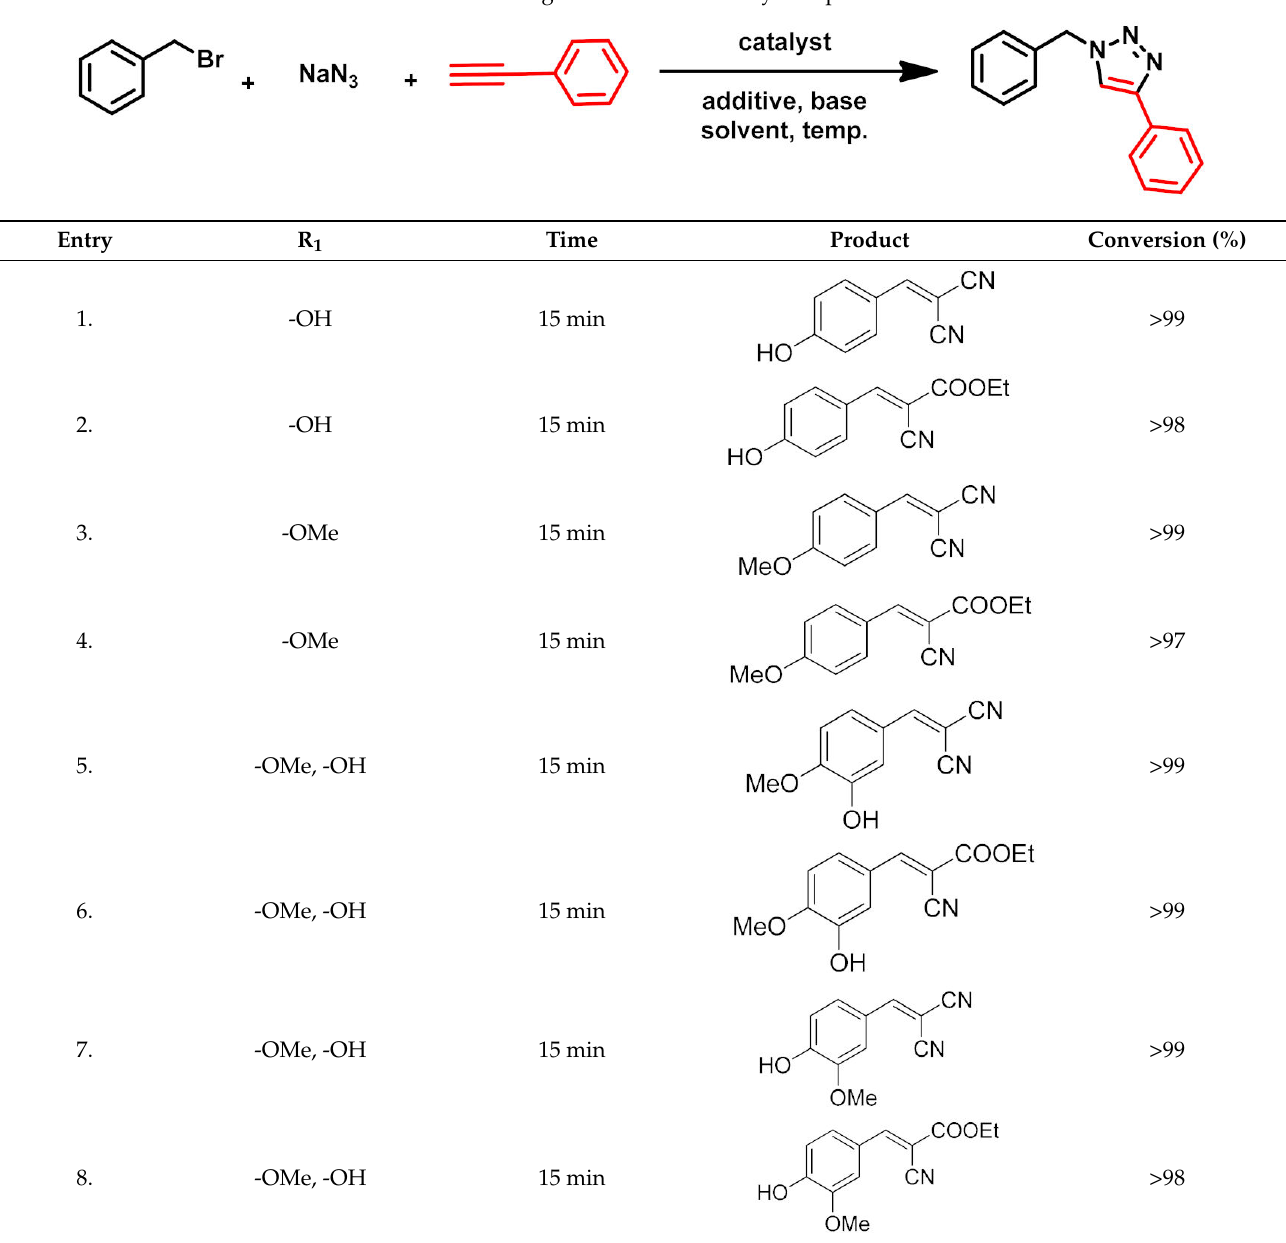
Table 4. Knoevenagel condensation catalytic